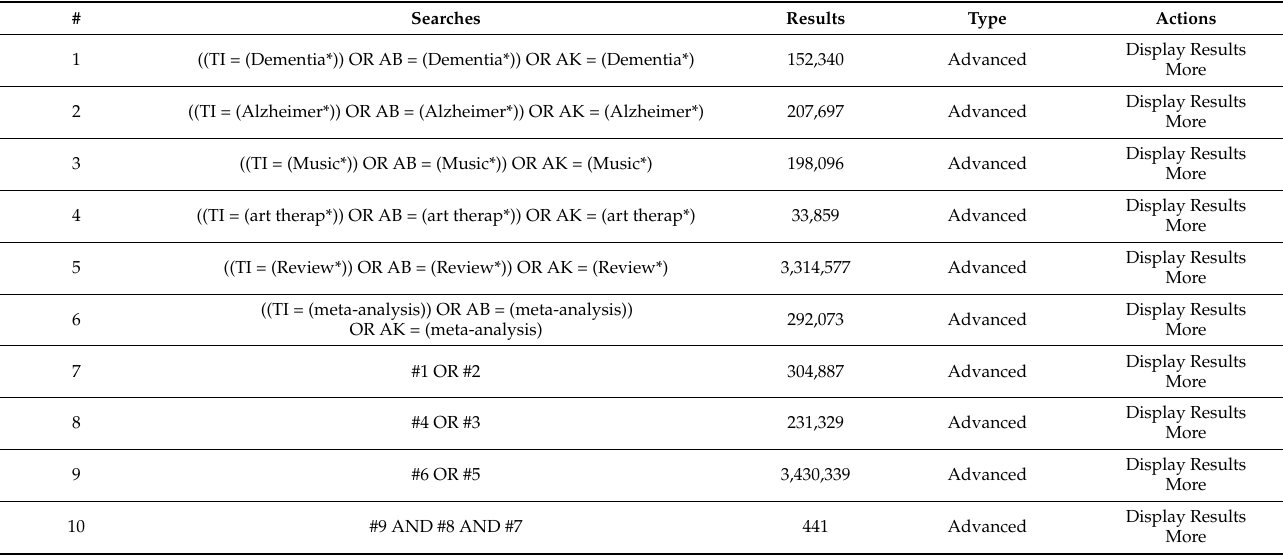
Table A2. ISI Web of Knowledge—11 January 2023.